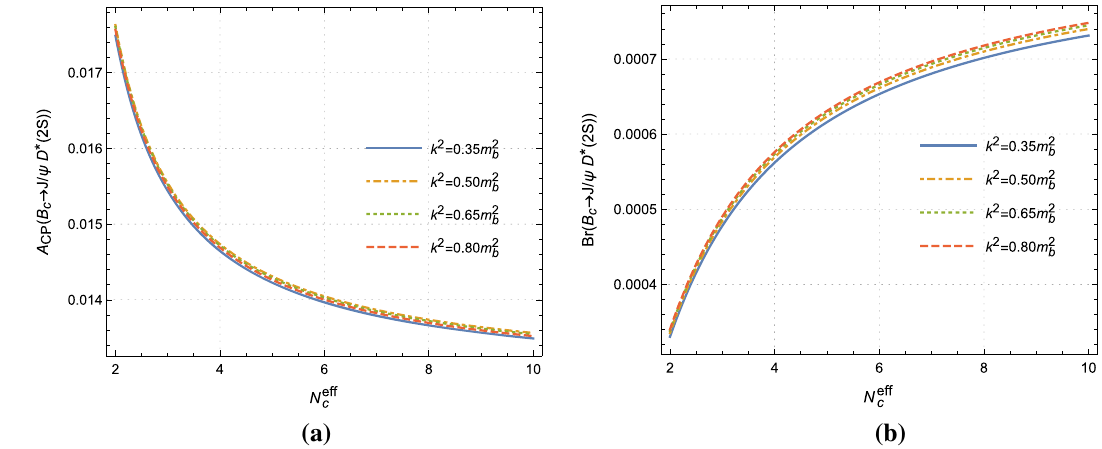
Fig. 9 A cp and averaged branching ratio of B c → J /ψ D ∗ ( 2 S ) change with k 2 and N ef f c